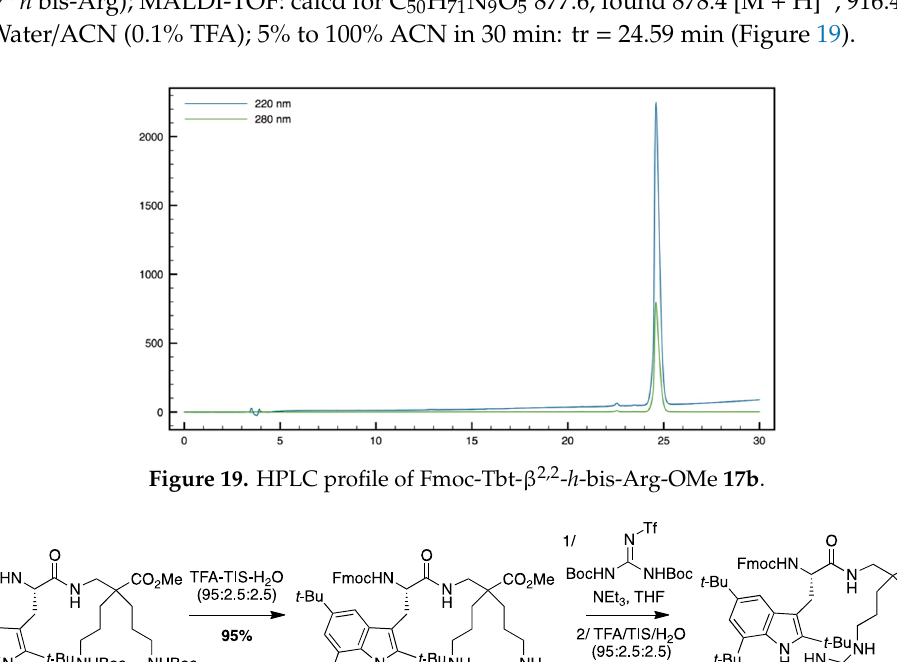
Figure 18 . HPLC profile of Fmoc-Tbt- β 2,2 -h-bis-Orn-OMe 17a